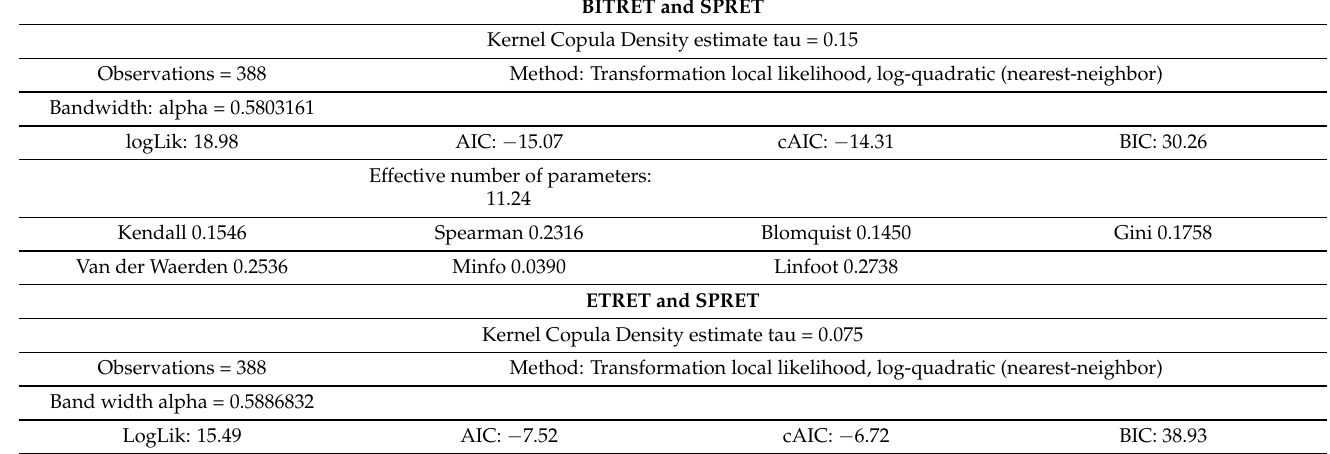
Table 9. Non-parametric Copula estimation-transformed returns Period 2. BITRET and SPRET Kernel Copula Density estimate tau =